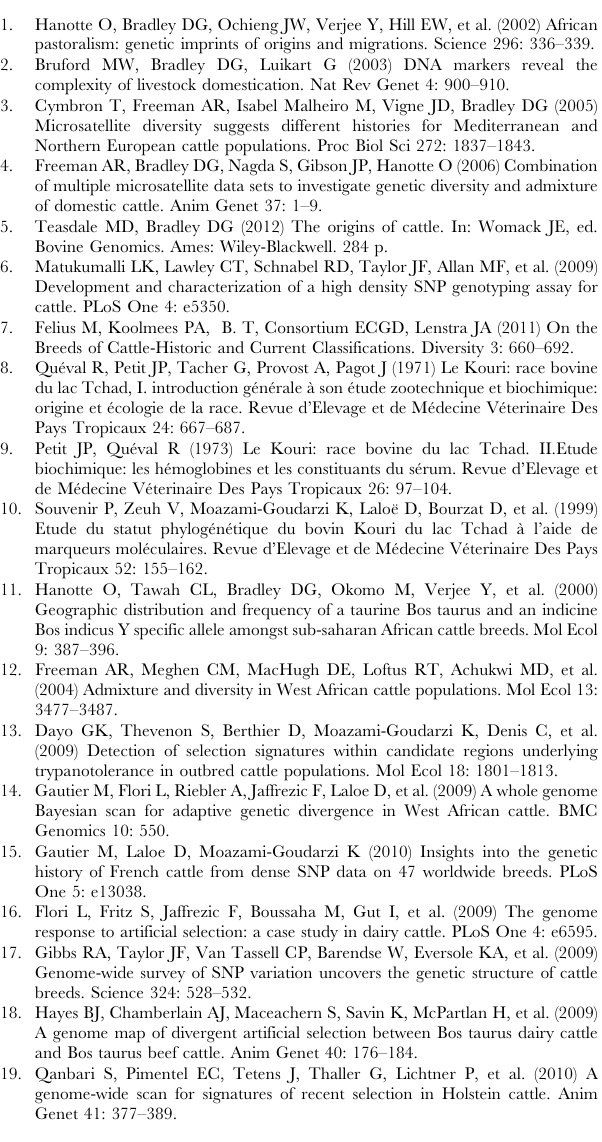
Table S2 Percentage of the corresponding AFT, ZEB and EUT ancestries for each breed. Table S3 Differentiation score ( Fst ) for all pairs of